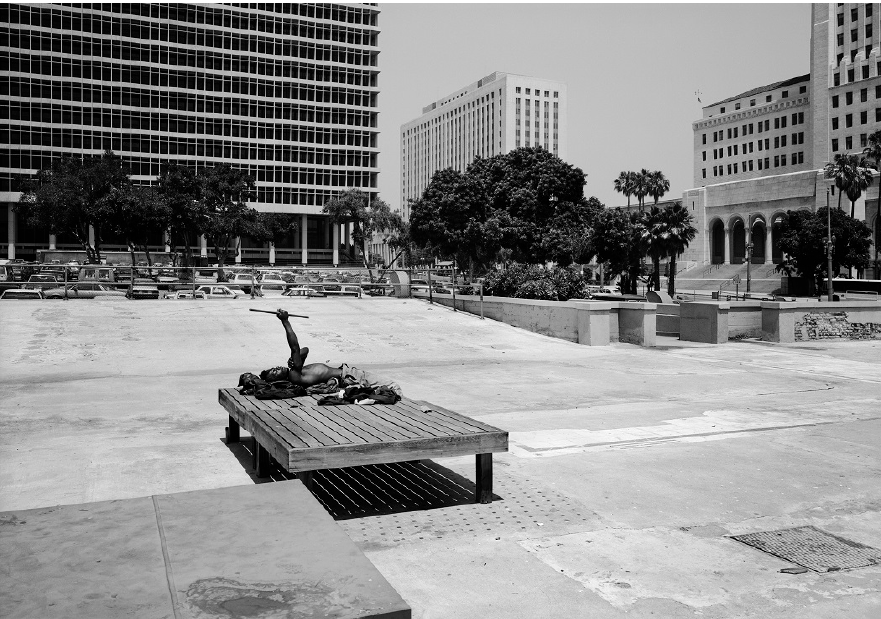
Figure 22. Anthony Hernandez Public Use Areas # 24 (1980), © Anthony Hernandez.